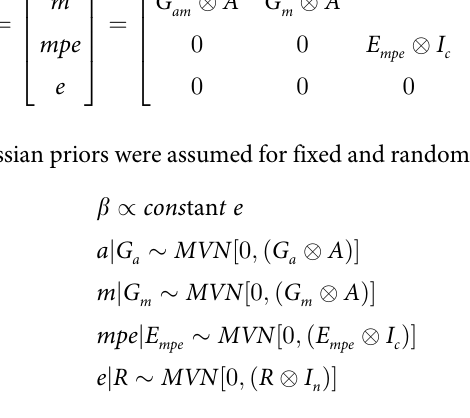
where G a and G m are (co)variance matrices of additive direct genetic effects and additive maternal additive genetic effects, respectively; G am is a matrix of additive genetic (co)variances between direct and maternal effects; E mpe is a (co)variance matrix of maternal permanent envi- ronmental effects; R is a (co)variance matrix of residual effects; A is the additive relationship matrix among all animals in the pedigree fi le; and I c and I n are identity matrices, whose orders were the numbers of dams and animals, respectively. The inverse Wishart distribution was